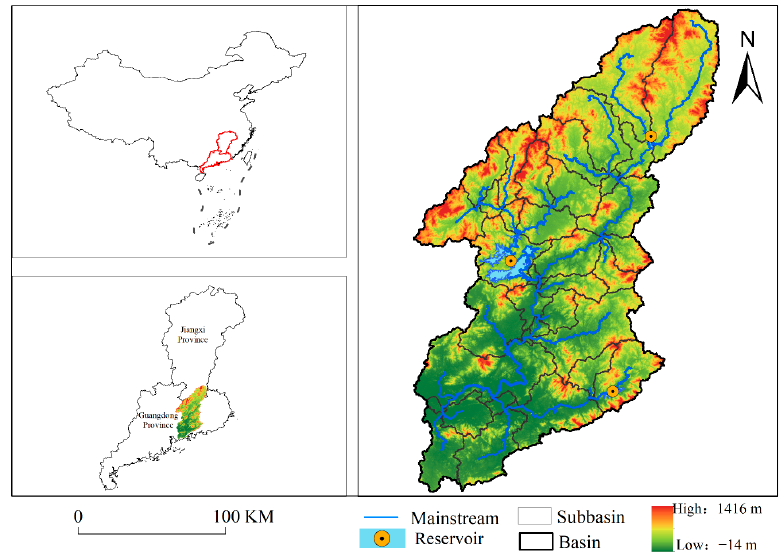
Figure 1. Study area. Table 1. Basic data.